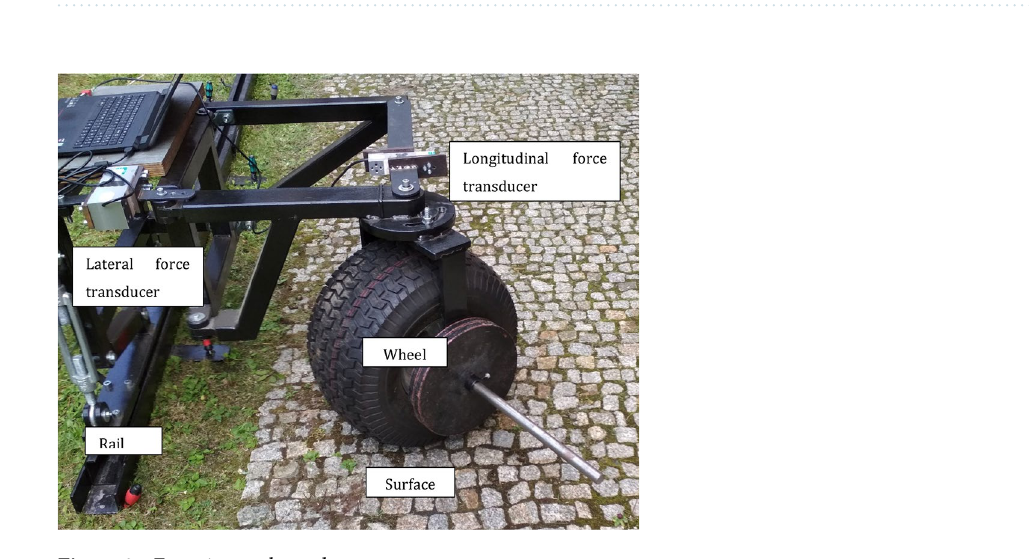
Figure 1. Ground tire interaction model.